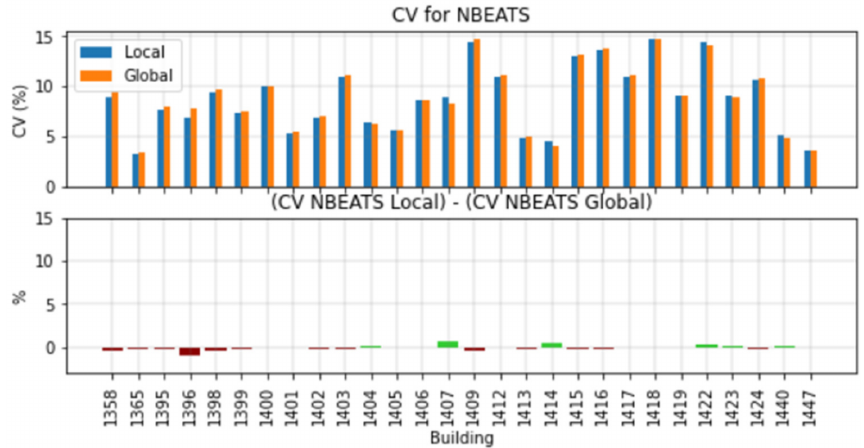
Figure 13. Comparison (in the upper figure) and difference (in the lower figure) between the CV obtained from local and global NBEATS models on test set.